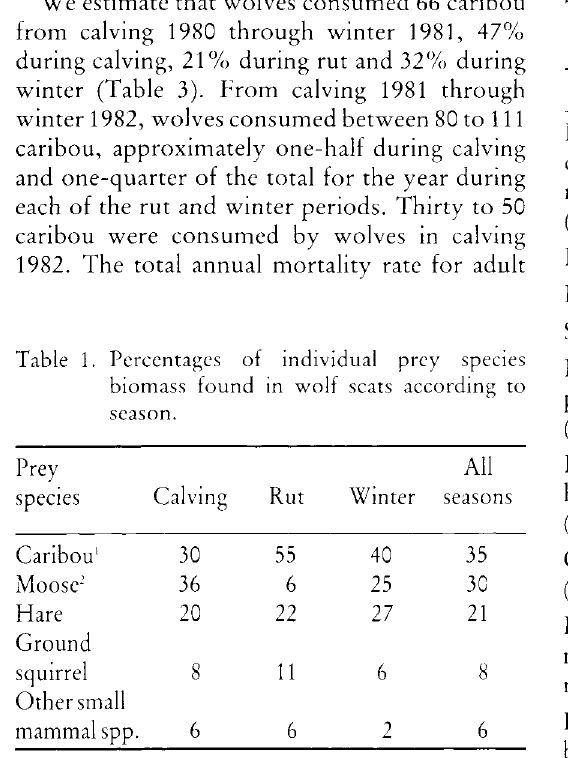
Table 3. Summary of sources of losses in